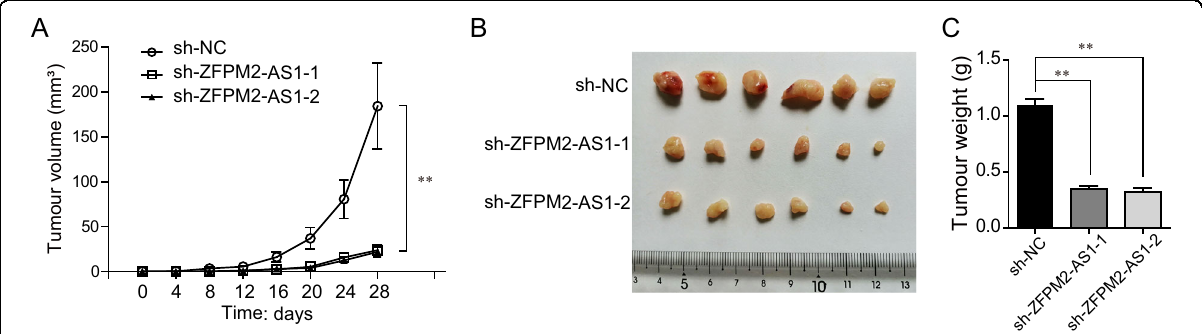
Fig. 4 The impact of ZFPM2-AS1 on HCC tumorigenesis in vivo. A Effects of ZFPM2-AS1 depletion in HepG2 cells on subcutaneous tumor growth. Tumor volumes were measured every 4 days. B Images of whole tumors from the nude mice injected with HepG2 cells stably infected with sh-NC, sh-ZFPM2-AS1-1, or sh-ZFPM2-AS1-2 lentivirus. C Tumor weights were measured after the tumors were harvested from indicated groups. Data are presented as the mean ± SD from three independent experiments. * P < 0.05, ** P < 0.01.